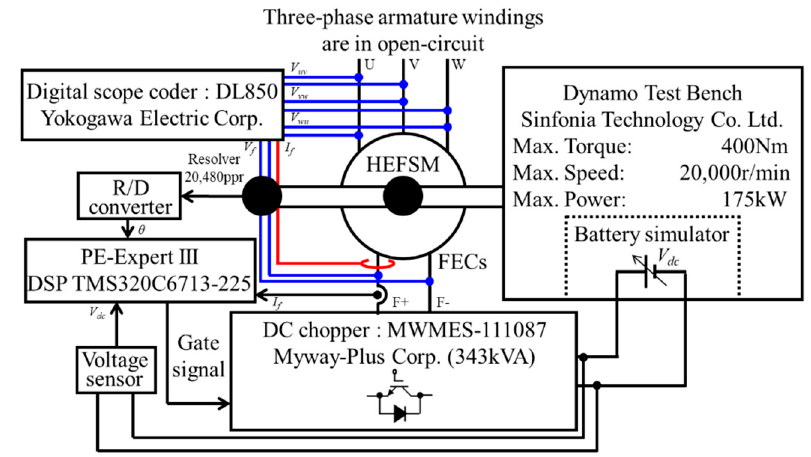
Figure 10. E xperimental setup for changing the magnetization state of VM-PMs. Figure 10. Experimental setup for changing the magnetization state of